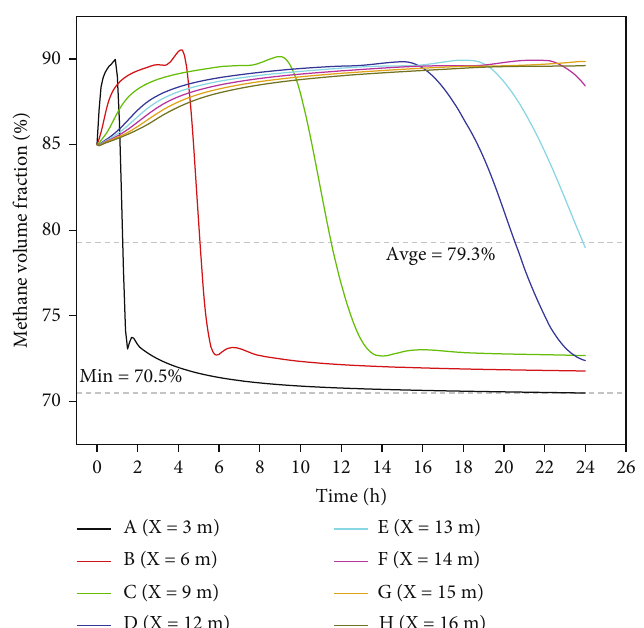
Figure 4: Time-dependent V at each detection point. X =3m: 3 m away horizontally from injection borehole. Avge: The average V CH 4 all detection points at the end of the displacement (24